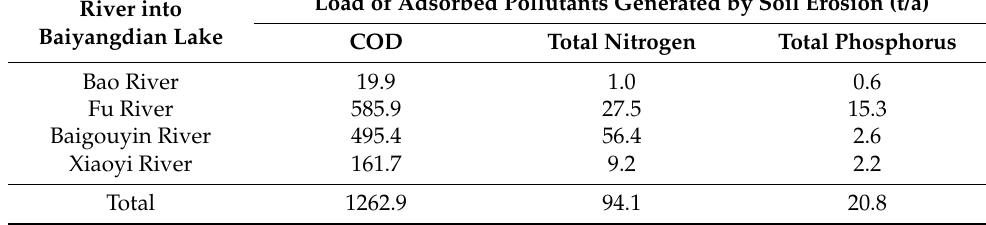
Table 2. The load of adsorbed pollutants generated by soil erosion.